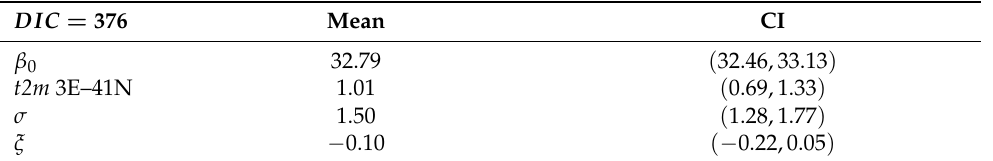
Table A2. Posterior mean and 95% CI of the GEV model parameters according to the GEV-SSVS selection between the 2 m surface temperature t2m variables. Barcelona (1914–2010).